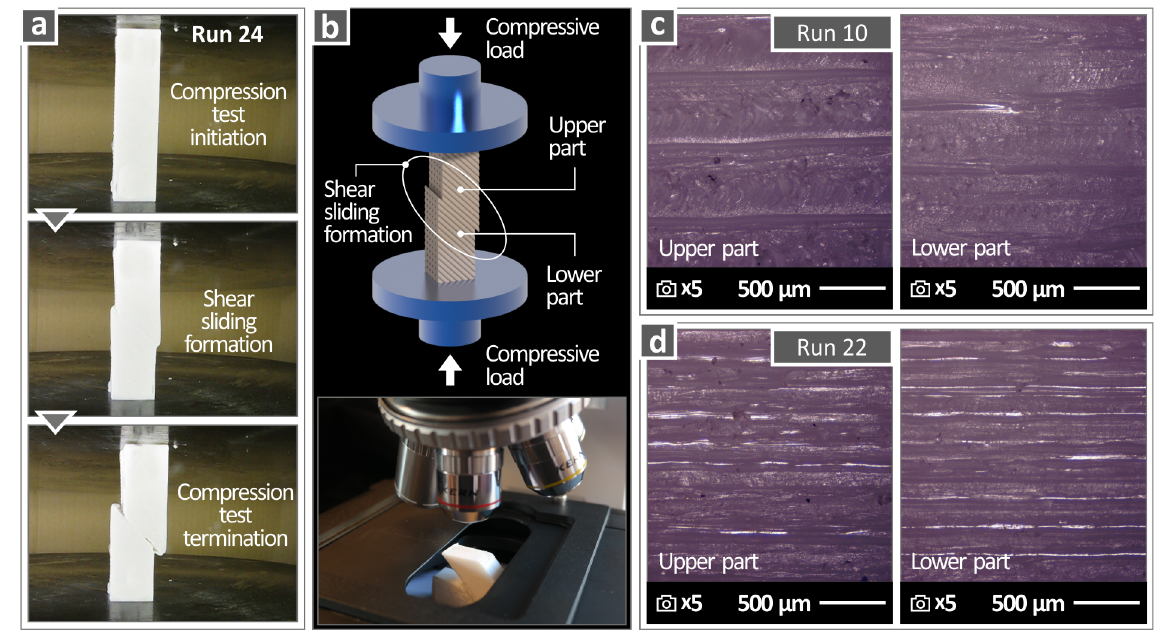
Figure 6. ( a ) Compression test of a 3D-printed specimen until failure (Run 24), ( b ) graphical representation of the compression test and microscopic inspection of the fracture surface, ( c , d ) micrograph images of the fracture surface of the upper and the lower part of two representative specimens (Run 10, 22) subjected to shear failure. Table 1. Taguchi L27 design: control parameters and